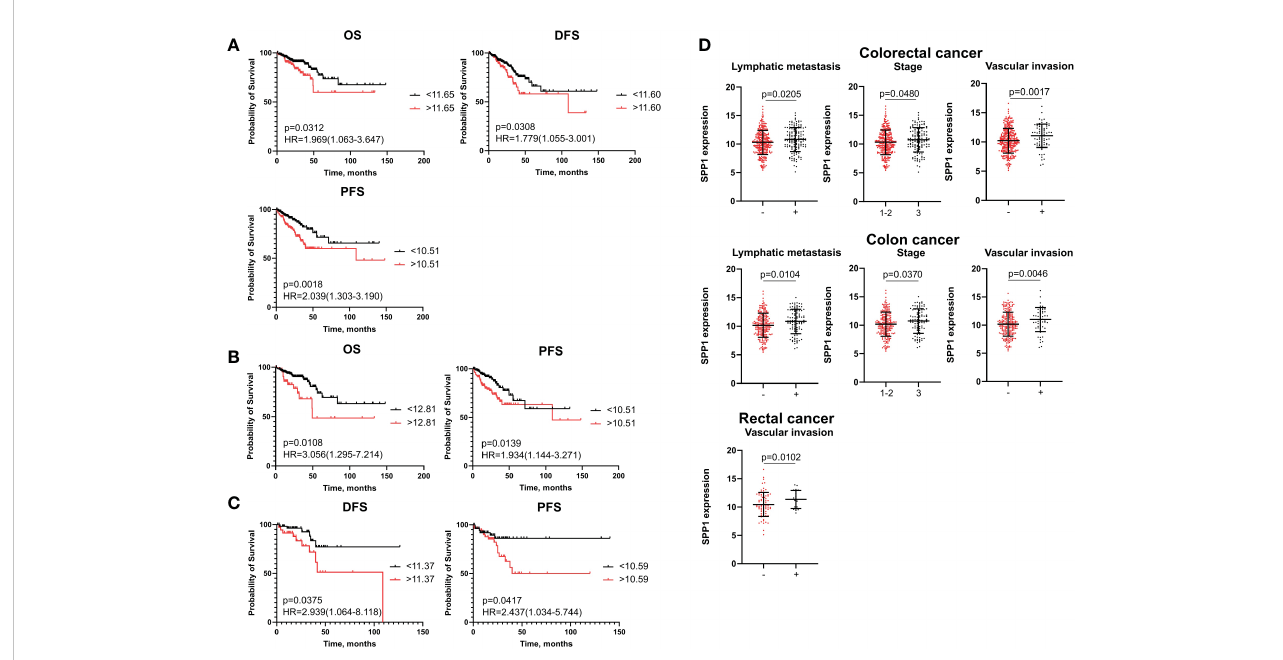
FIGURE 3 SPP1 mRNA expression is associated with poor survival and clinical-pathological parameters. (A) Kaplan – Meier curve of TCGA survival data (OS, DFS, and PFS) for high-risk and low-risk patients in combined CRC group. (B) Kaplan – Meier curve of TCGA survival data (OS and PFS) for high-risk and low-risk groups in colon cancer patients. (C) Kaplan – Meier curve of TCGA survival data (DFS and PFS) for high-risk and low-risk groups in rectal cancer patients. Log-rank test p-values are shown in Kaplan – Meier curves. (D) SPP1 mRNA expression is associated with lymph node, tumor stage and vascular invasion in CRC patients and colon cancer patients, and with vascular invasion in rectal cancer patients. Student ’ s t-test was applied. Scatter plots depict gene expression as mean with